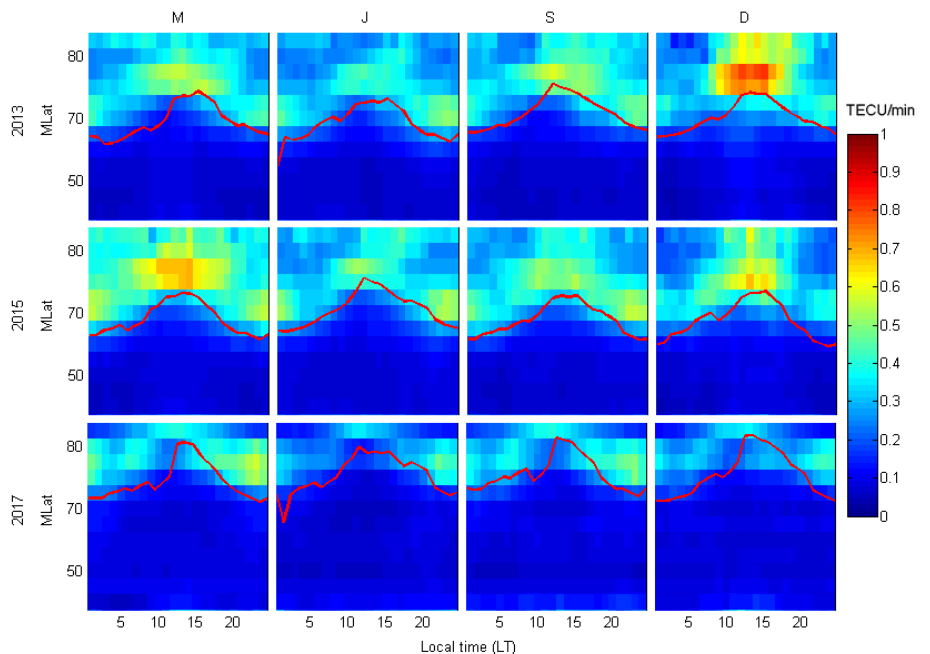
Figure 11. The same as Figure 8 but for the North-American